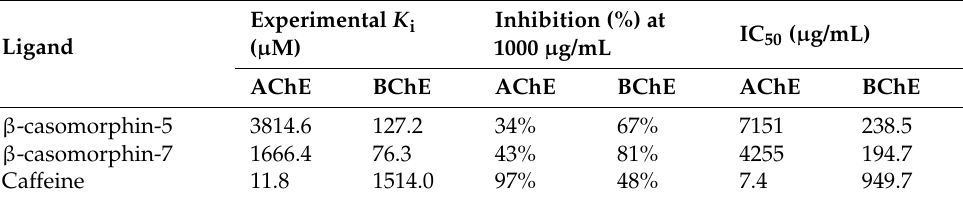
Table 6. Experimental dissociation constants, inhibition (%), IC50 values, and equivalents of the opioid peptides against AChE and